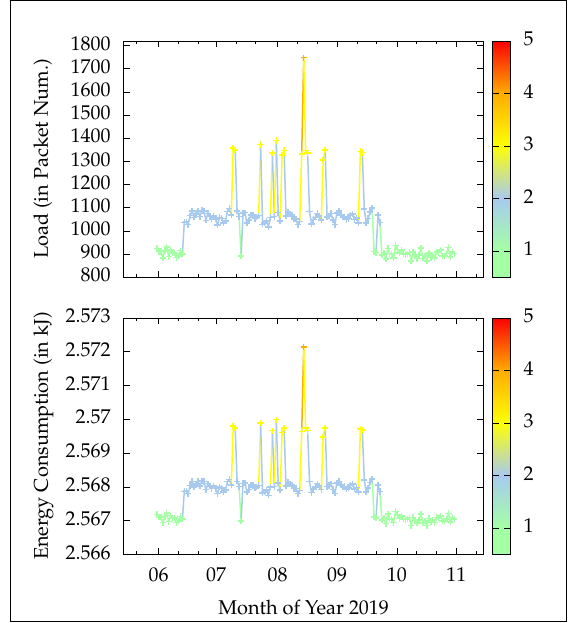
Figure 11. The traffic load, i.e., the number of transmitted packets (upper part), versus the corresponding energy consumption (bottom part) in kJ, per day of the firefighting season of 2019.